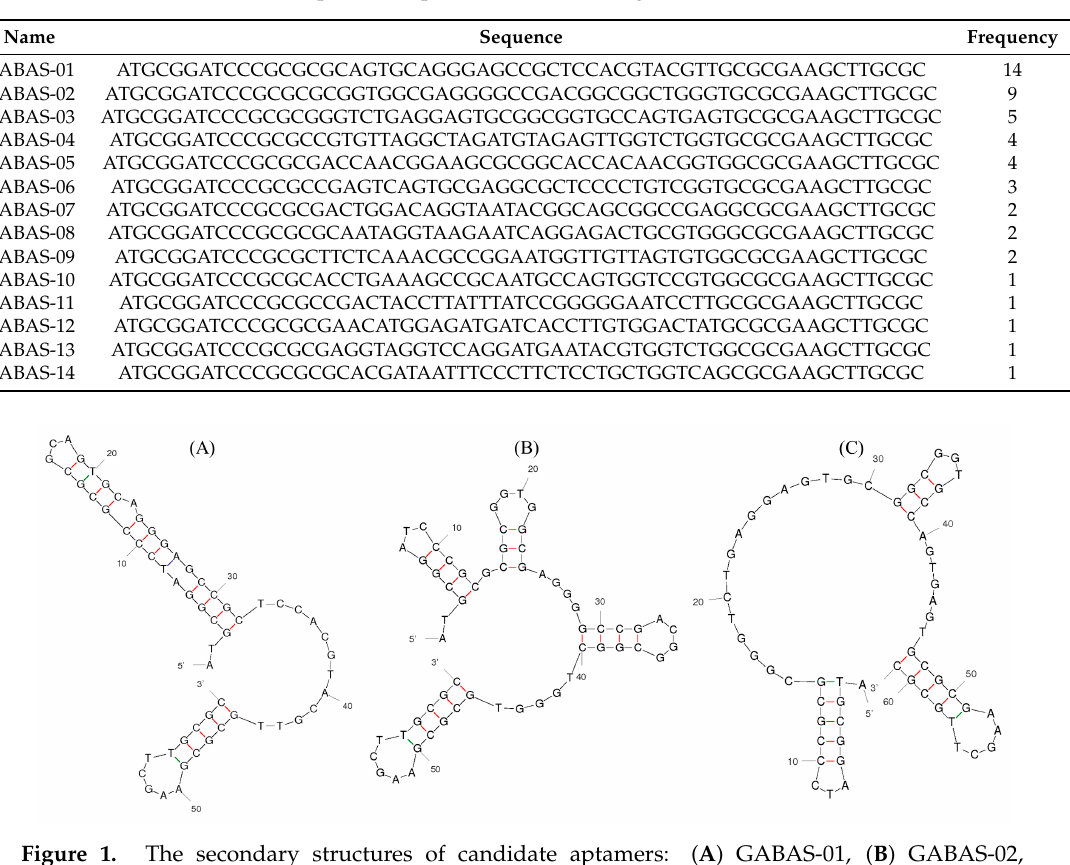
Table 2. Aptamer sequences after screening with rGO-SELEX. Table 1. Aptamer screening condition of each rounds with rGO-SELEX.